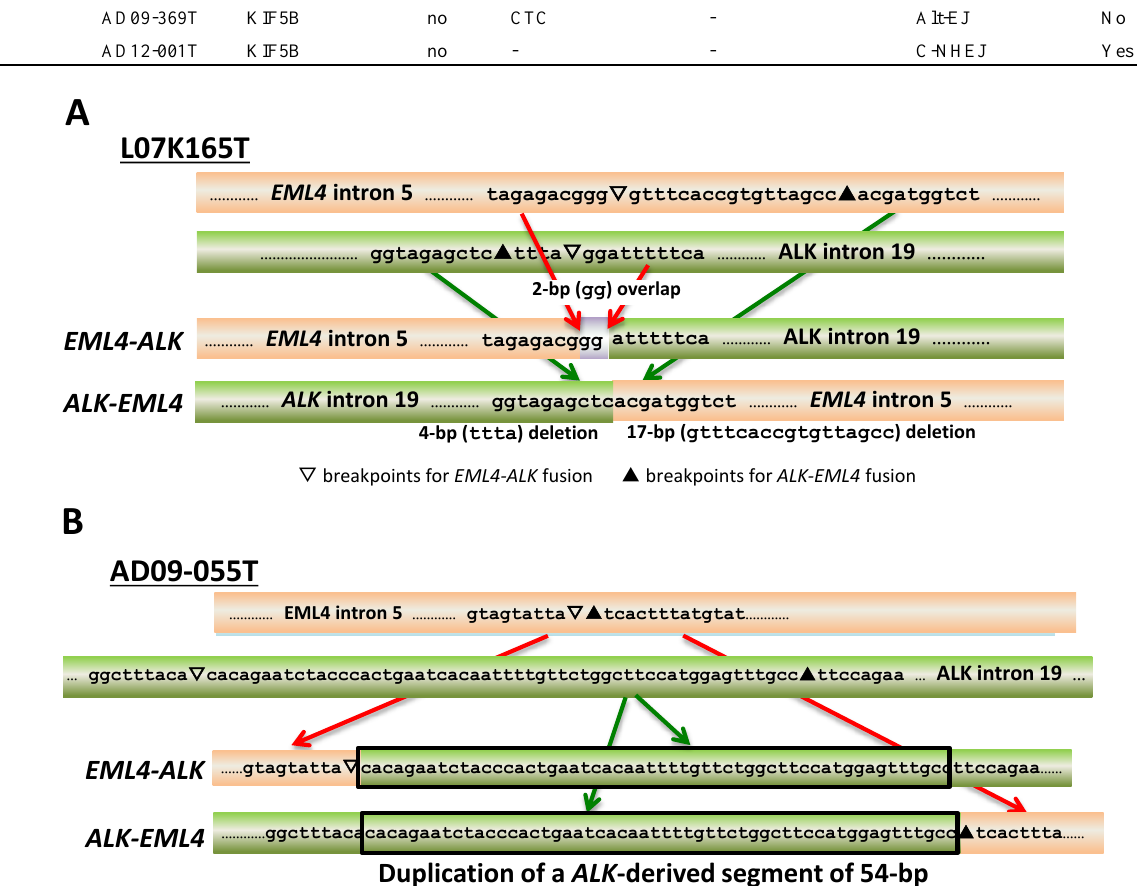
Duplication of a ALK -derived segment of 54-bp